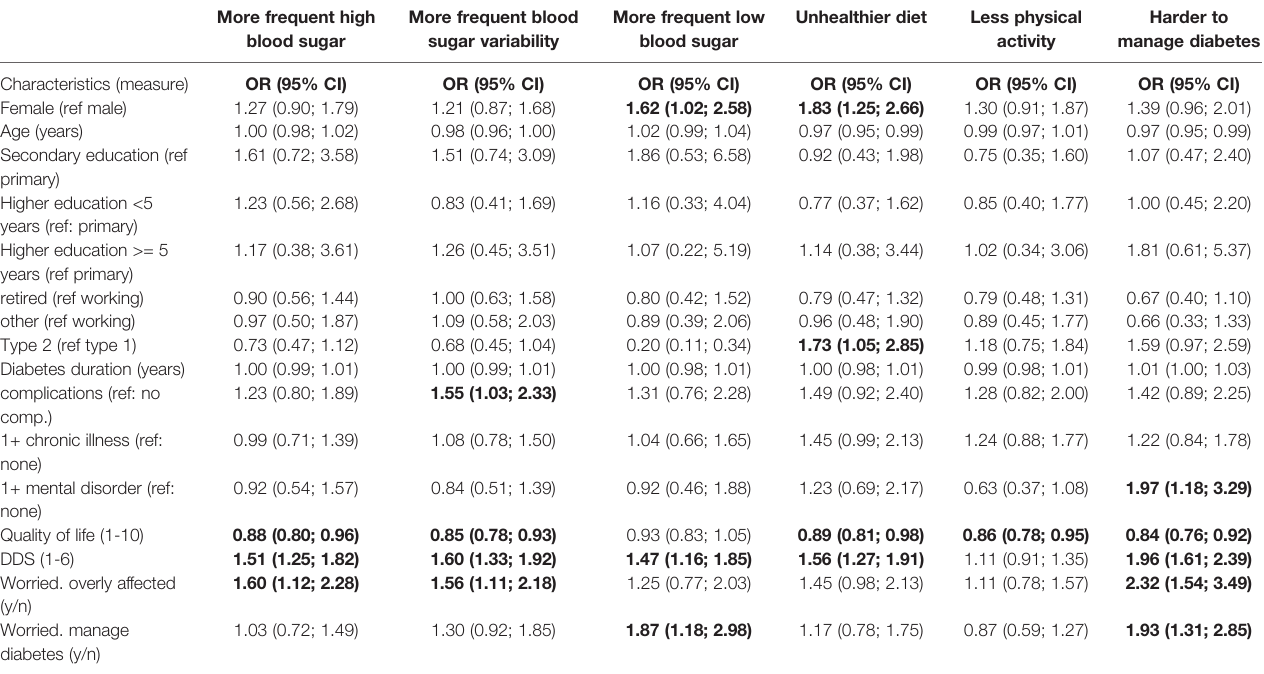
TABLE 3B | Predictors of reporting worse diabetes management behaviors during the